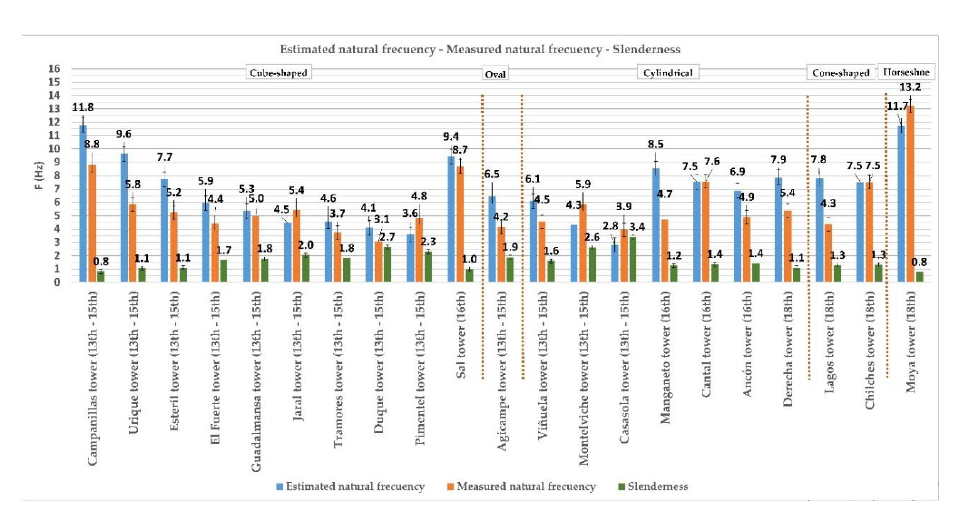
Figure 20. Comparison between the estimated natural frequency (blue), measured frequency (orange), and slenderness (green) for each tower.